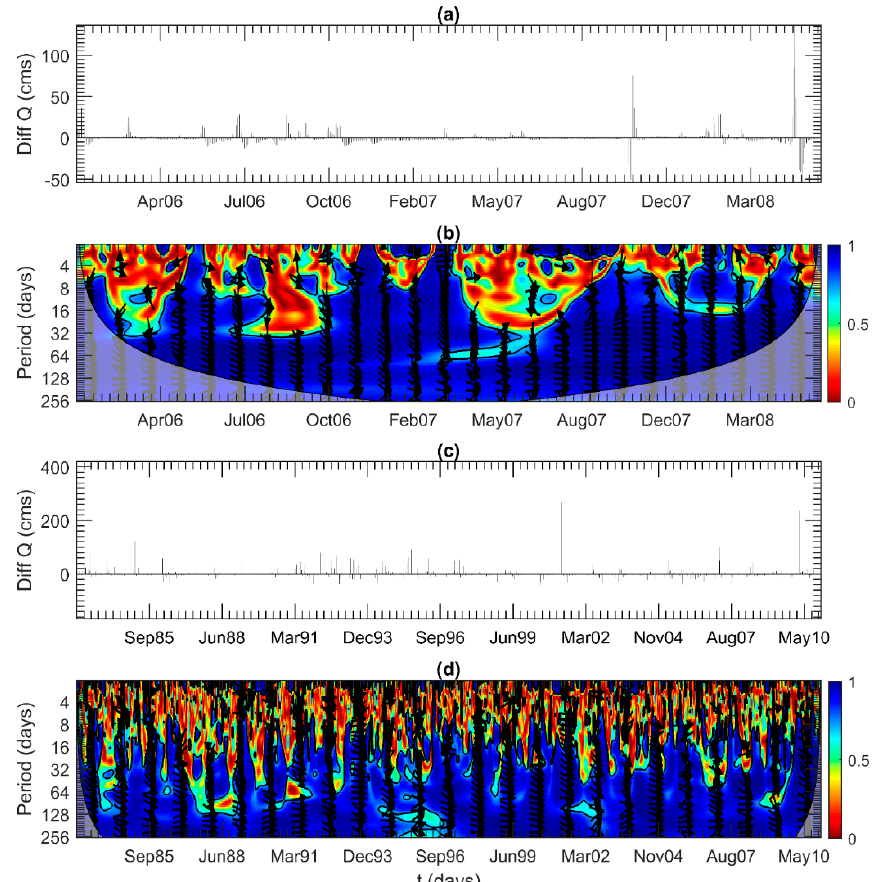
Figure 7. ( a , c ) Euclidian metric (between measured vs. simulated) for the Le Sueur River at St. Clair gage and Le Sueur River near Rapidan, MN 66 gage in the Le Sueur River Basin (LSRB) respectively. ( b , d ) Dissimilarity in time-scale domain between the measured and predicted signals are illustrated with the Wavelet Transform Coherence (WTC) for the Le Sueur River at St. Clair gage and Le Sueur River near Rapidan, MN 66 gage in LSRB respectively. The cone of influence is represented using a lighter shade (region where edge effects become dominant). The abscissa is time and the ordinate is the wavelet scale equivalent to the Fourier period. The coherence value is encoded by color. The low coherence in the ~<16 days period band is attributable to the inability of the model to capture higher frequency peak flows.